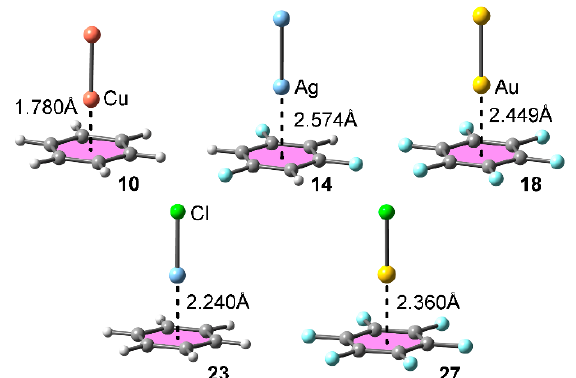
Figure 2. Optimized geometries of complexes 10 , 14 , 18 , 23 and 27 at the RI-MP2/def2-TZVP level of theory.